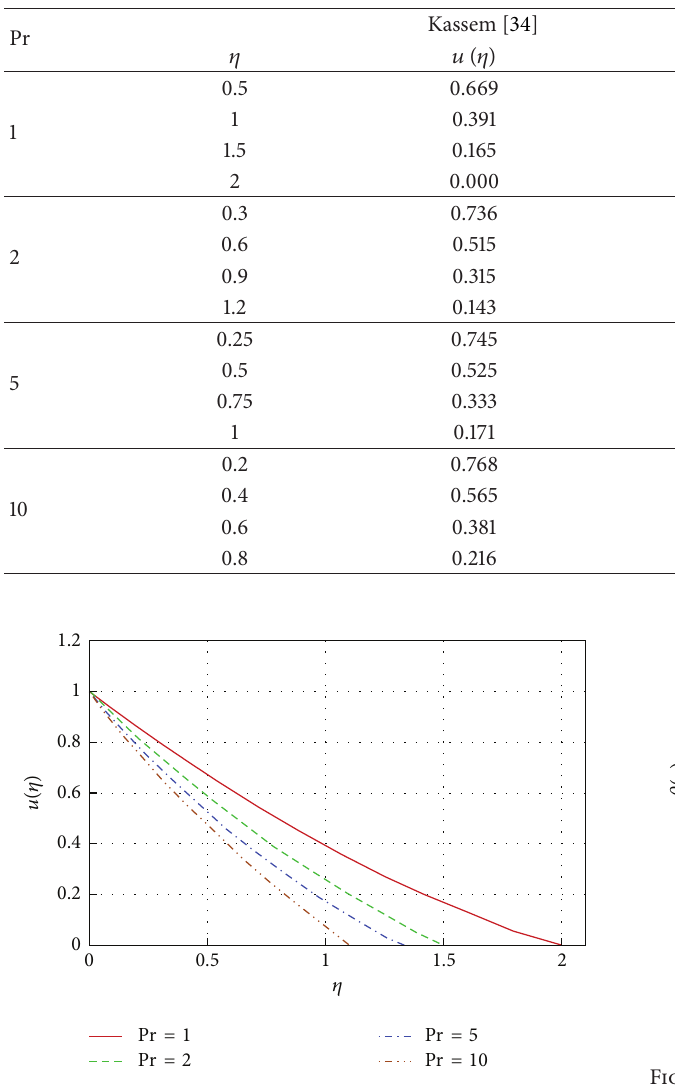
Figure 2: Vertical velocity of Newtonian fluid at the vicinity of stretching sheet for different values of Pr.